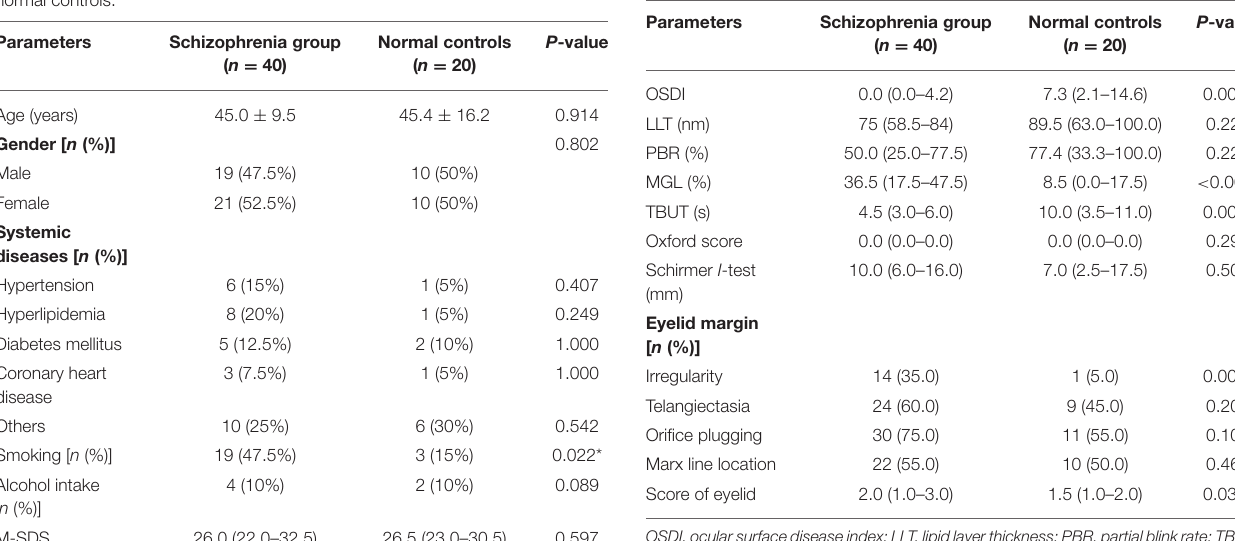
TABLE 2 | Ocular surface clinical outcomes in controls and schizophrenia